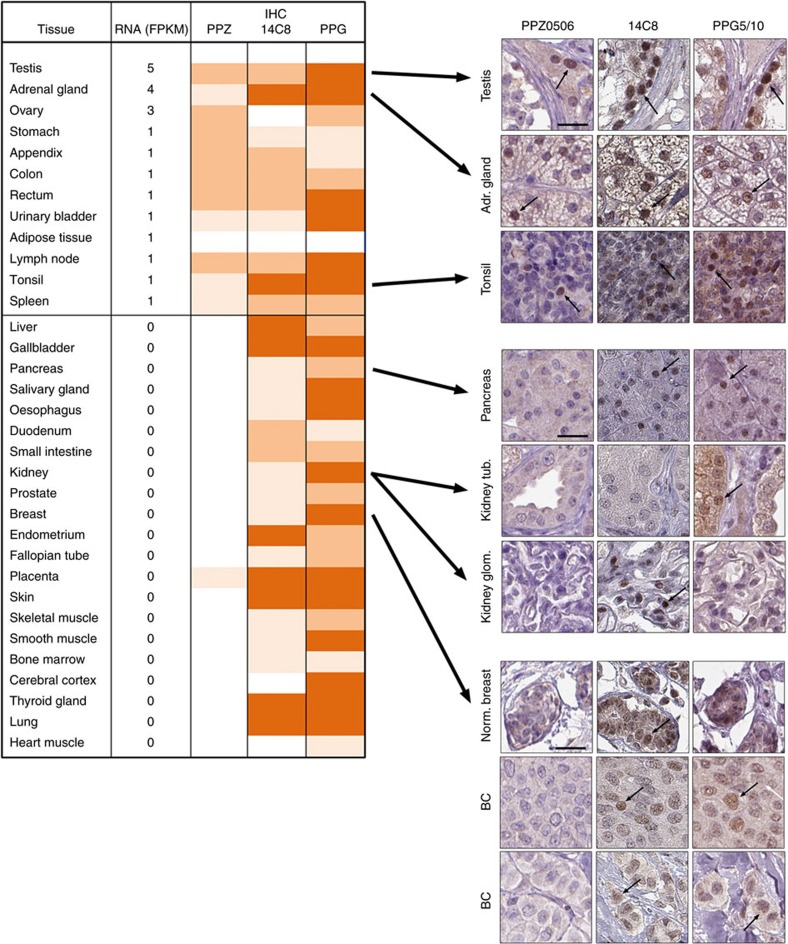
IHC with PPZ0506 but not 14C8 or PPG5/10 shows congruency with transcript levels in large panel of tissues.Left panel: ERβ mRNA and protein expression in the Human Protein Atlas tissue panel. Average ERβ transcript levels (FPKM) measured using RNA-seq in triplicate tissue samples of 33 normal tissues displayed alongside annotated IHC positivity generated with antibodies PPZ0506 (1:600), 14C8 (1:1,500), and PPG5/10 (1:60), respectively. Annotated IHC positivity is dichotomized into grades 1-3, represented by colours (1: light brown, 2: medium brown, 3: dark brown). Right panel: Representative examples of IHC stainings generated using antibodies PPZ0506, 14C8 and PPG5/10, respectively. Top panel: Tissues with congruent IHC staining; Middle panel: tissues in which PPZ0506 generates a negative result while positivity is seen using 14C8 and PPG5/10; Lower panel: breast and breast cancer tissue in which positivity is seen using 14C8 and/or PPG5/10, while PPZ0506 generates a negative result. Brown: positive IHC staining; Blue: hematoxylin counter staining. BC: breast cancer. Scale bar in top left images indicates 25 μm. Arrows indicate examples of cells with nuclear staining.